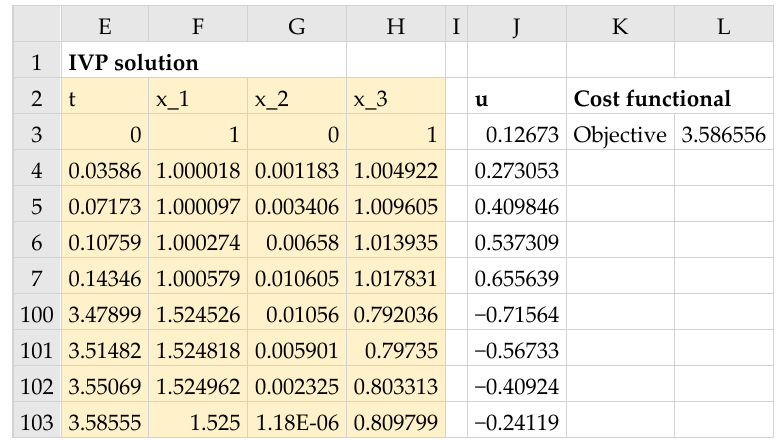
Figure 24. Partial listing of the updated initial result of Figure 21 which reflects the optimal final time and adjusted output time values in Column E.